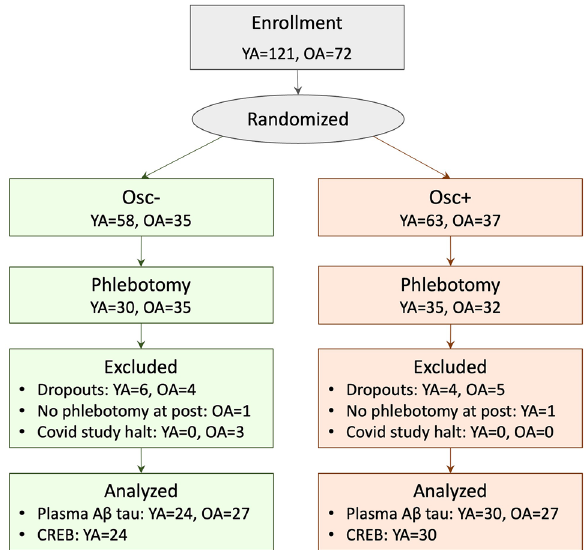
Figure 3. Flow chart. The phlebotomy took place for a subset of the total participants. The whole intervention had 15 dropouts for younger adults (7 Osc+, 8 Osc−) and 16 dropouts including 6 Covid-induced study halts for older adults (9 Osc+, 7 Osc−). Among 6 Covid-halted cases (all older adults), three participants were included for plasma assays because they completed up to Week 6 sessions including